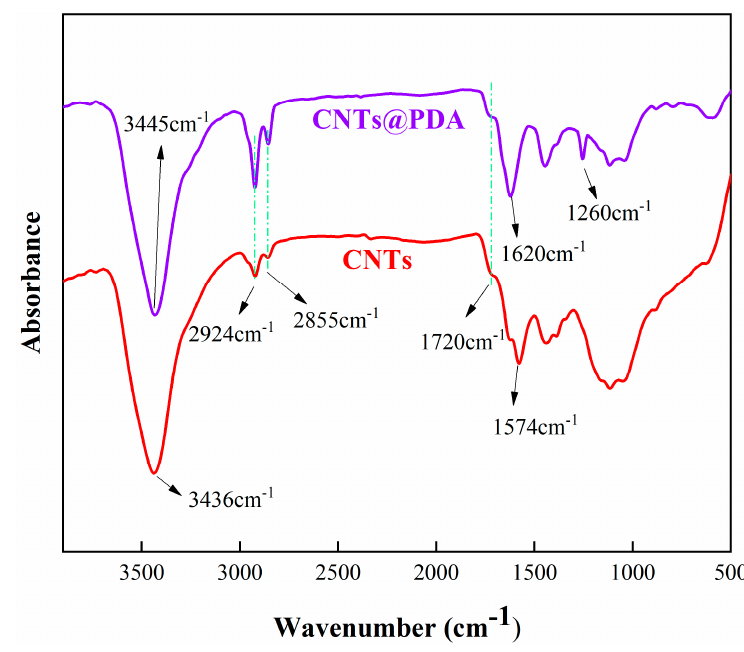
Figure 2. FTIR spectra of CNTs and CNTs@PDA.